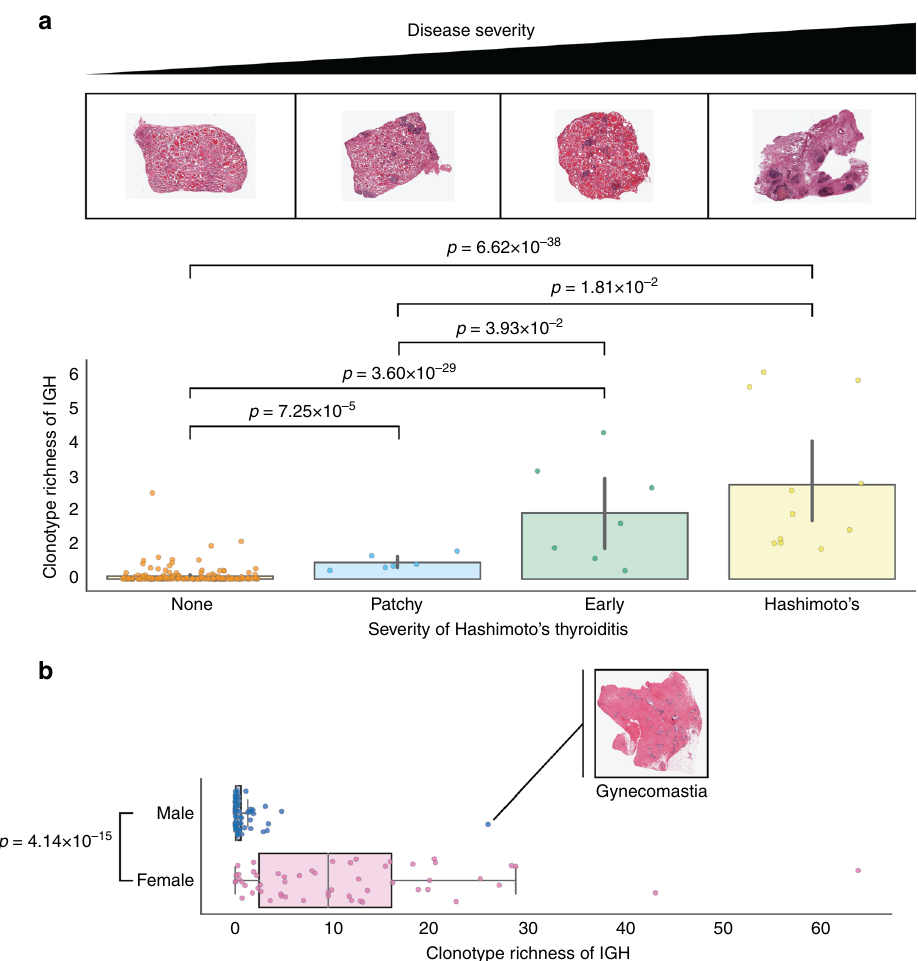
Fig. 6 ImReP is able to identify samples with high activity of lymphocytes. Histological images of tissue cross-sections and pathologists ’ notes are used to validate the ability of ImReP to detect samples with a high activity of lymphocytes. a Samples were ordered by the individual ’ s severity of Hashimoto ’ s thyroiditis, as reported by pathologists ’ notes: None ( n = 180), Patchy ( n = 6), Early ( n = 7), and Hashimoto ’ s ( n = 11). Histological images are provided to illustrate each disease state. Bar plot reports clonotypic richness of IGH, calculated as the number of distinct amino acid sequences of CDR3 per one million RNA-seq reads (CPM). The p -values were generated using a two-sided, two-sample t -test for each pair of severities (None vs. Patchy: t = − 4.06 and p -value = 7.25 × 10 − 5 ; None vs. Early: t = − 13.44 and p -value = 3.60 × 10 − 29 ; None vs. Hashimoto ’ s: t = − 16.31 and p -value = 6.62 × 10 − 38 ; Patchy vs. Early: t = − 2.34 and p -value = 3.93 × 10 − 2 ; Patchy vs. Hashimoto ’ s: t = − 2.65 and p -value = 1.81 × 10 − 2 ; Early vs. Hashimoto ’ s: t = − 0.92 and p -value = 0.37). Error bars represent the 95% con fi dence interval around the mean. b Boxplot reporting clonotypic richness of IGH, calculated as the number of distinct amino acid sequences of CDR3 per one million RNA-seq reads (CPM), in the breast tissues for males ( n = 73, min = 0.01, Q 1 = 0.09, median = 0.19, Q 3 = 0.63, max = 25.93) and females ( n = 55, min = 0.04, Q 1 = 2.50, median = 9.56, Q 3 = 16.05, max = 63.80). The extreme outlier among the male samples is illustrated with the histological image. Each boxplot represents the median and interquartile range, with whiskers extending to 1.5 times the interquartile range. We detect a signi fi cant difference between the clonotypic richness of IGH in the breast tissue of males and females (two-sided Mann – Whitney U -test: U = 376, p -value = 4.14 × 10 − 15 ). Source data are provided as a Source Data fi